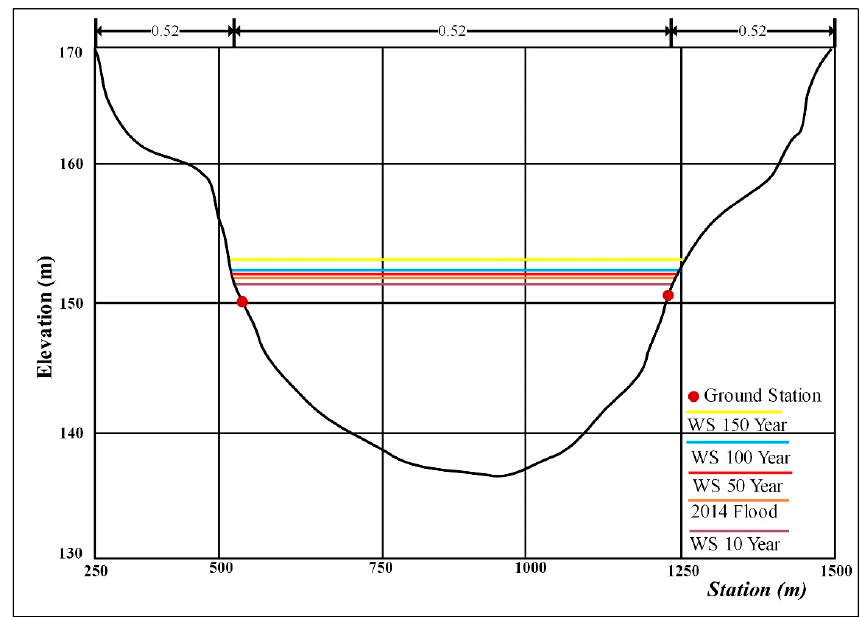
Figure 7. Water level for floods with different return periods 1118 m downstream from Taunsa Barrage.